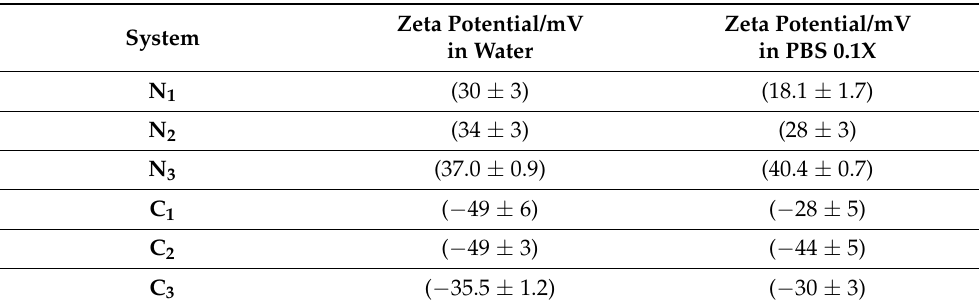
Table 1. Zeta potential of Au@16-Ph-16 precursors (N I ) and Au@16-Ph-16/DNA–Doxo compacted